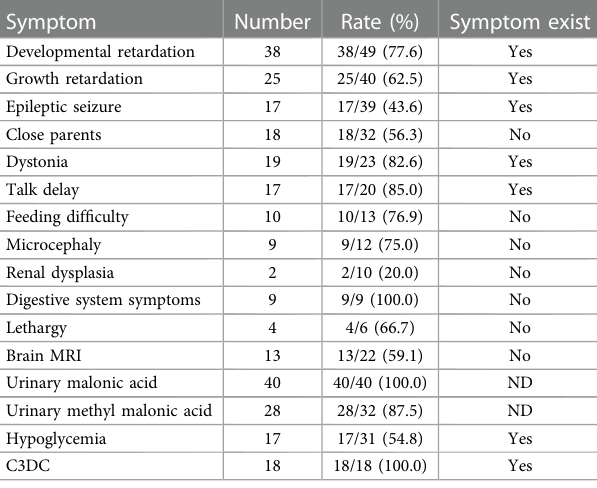
TABLE 2 Manifestation and auxiliary examination of reported children with MLYCDD.